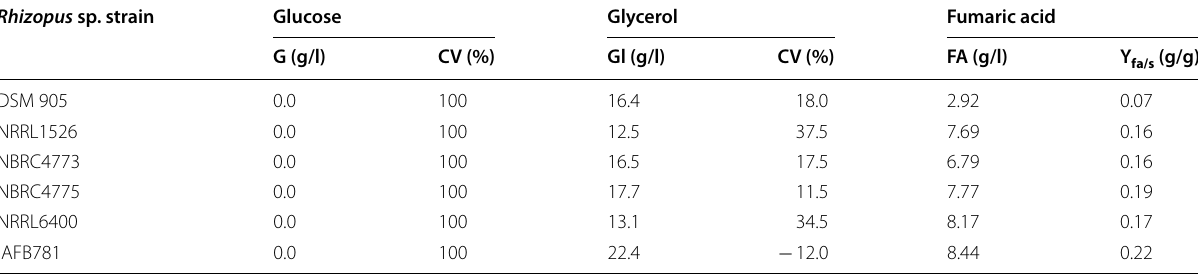
Table 4 Fumaric acid production from glycerol to glucose by various strains of Rhizopus sp. after 168 h of growth (35 °C, 200 rpm)